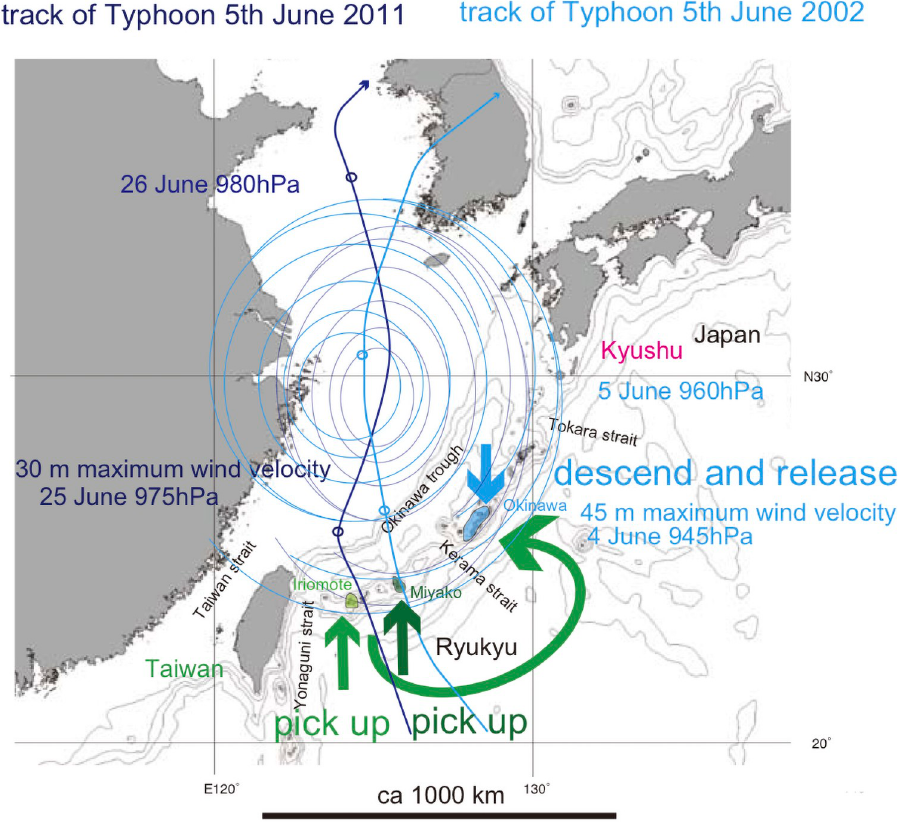
Fig 13. Track of track of Typhoon 5, June 2002 (medium blue curved path) and track of Typhoon 5, June 2011 (very dark blue sinuous path), and hypothetical 350~500 km transport Mogannia minuta by the marginal typhoon winds (green curved path). The bold short arrows schematically (not to scale) show where the typhoon winds picked up cicada (green and dark green) and where the same cicada were released (blue). Base map from Vector Map (VMap) Level